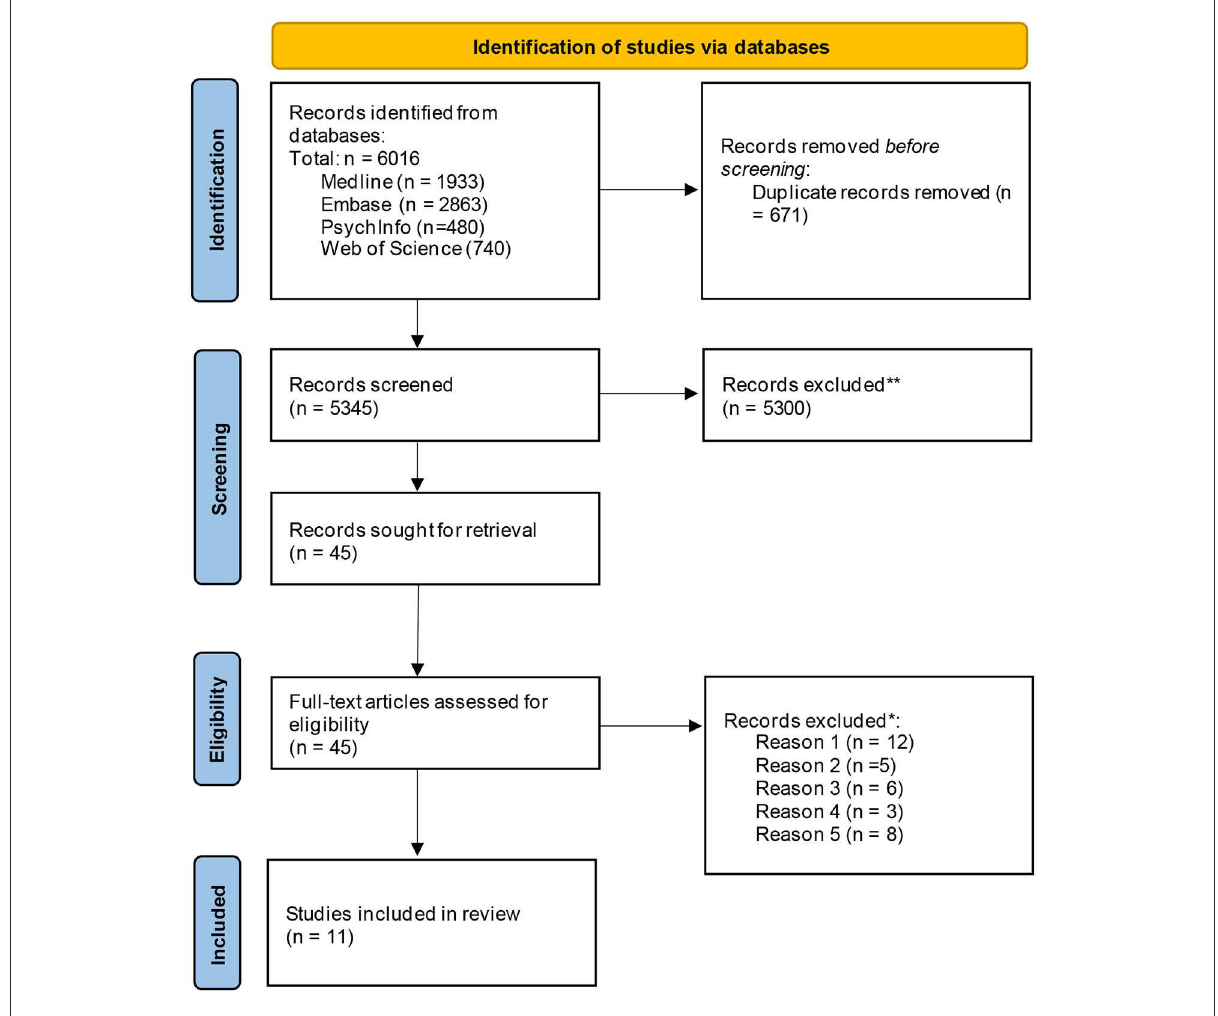
FIGURE1 PRISMA flow diagram of paper selection